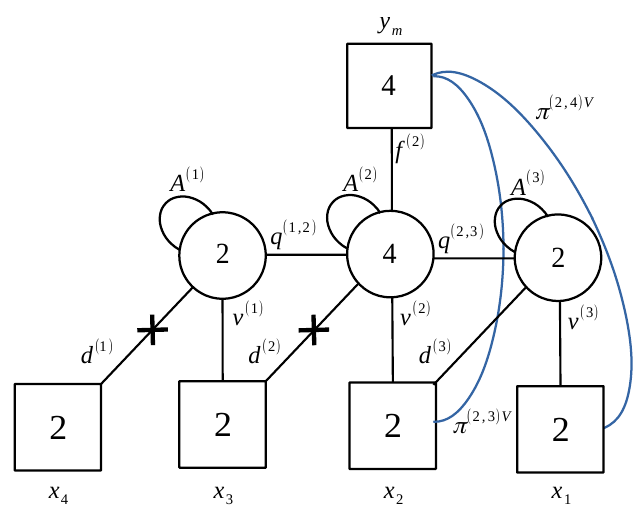
and (cid:13) _ , 11 11